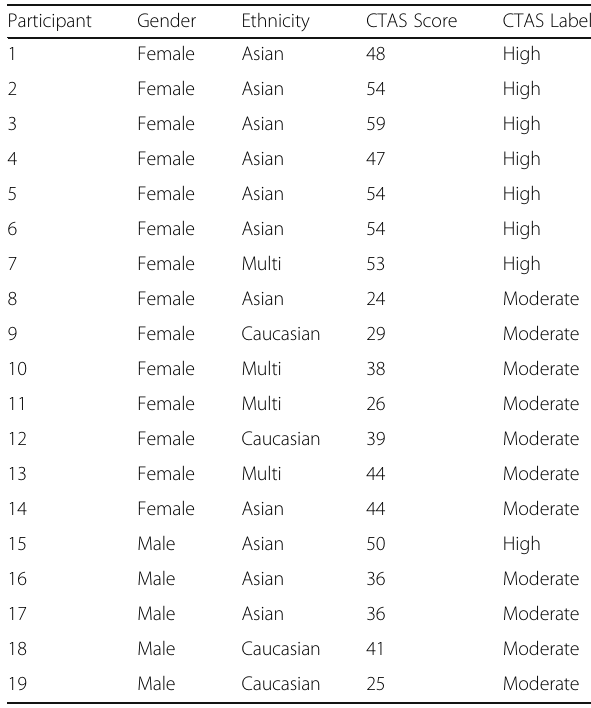
Table 1 List of study participants gender, ethnicity, CTAS score, and CTAS score